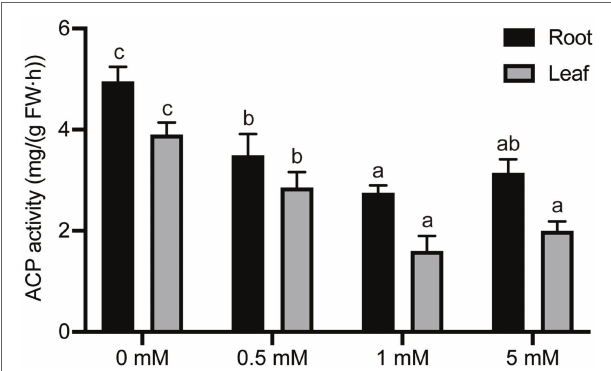
FIGURE 6 | The effect of different P treatments on the acid phosphatase (ACP) activity in pear seedlings. Response of intercellular ACP activity in pear seedling root and leaf tissue to P concentration. Data are presented as mean ± standard deviation of three replicates, and each replicate is based on measurements made from three plants. Samples in a bar chart with a common superscript letter are not significantly different ( p > 0.05), according to the Duncan’s multiple range